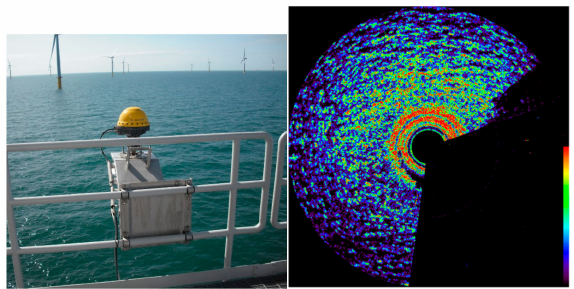
Figure 3. Example of ground-based wave radar system ( left ) [75] and its output ( right )